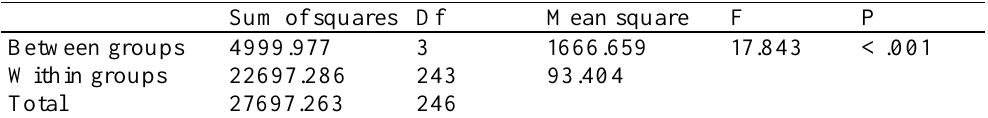
One-way Analysis of Variance for SOC Sum of squares Df Mean square F P Between groups 4999.977 Within groups 22697.286 243 93.404 Total